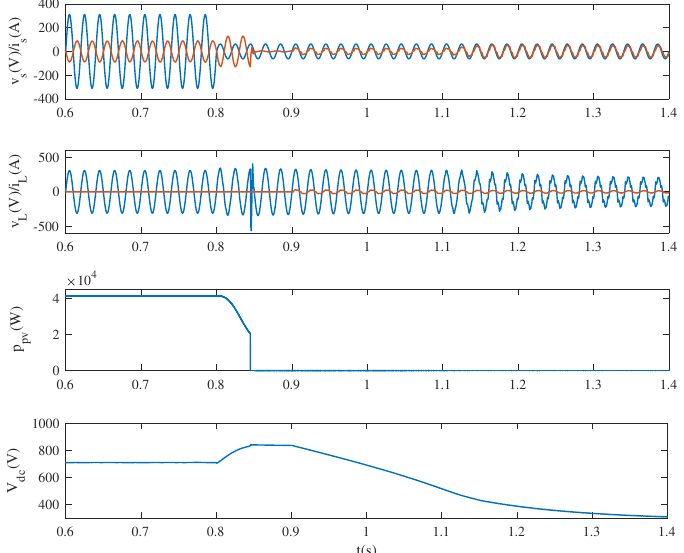
Figure 17. Simulation results under voltage sag of 0.8